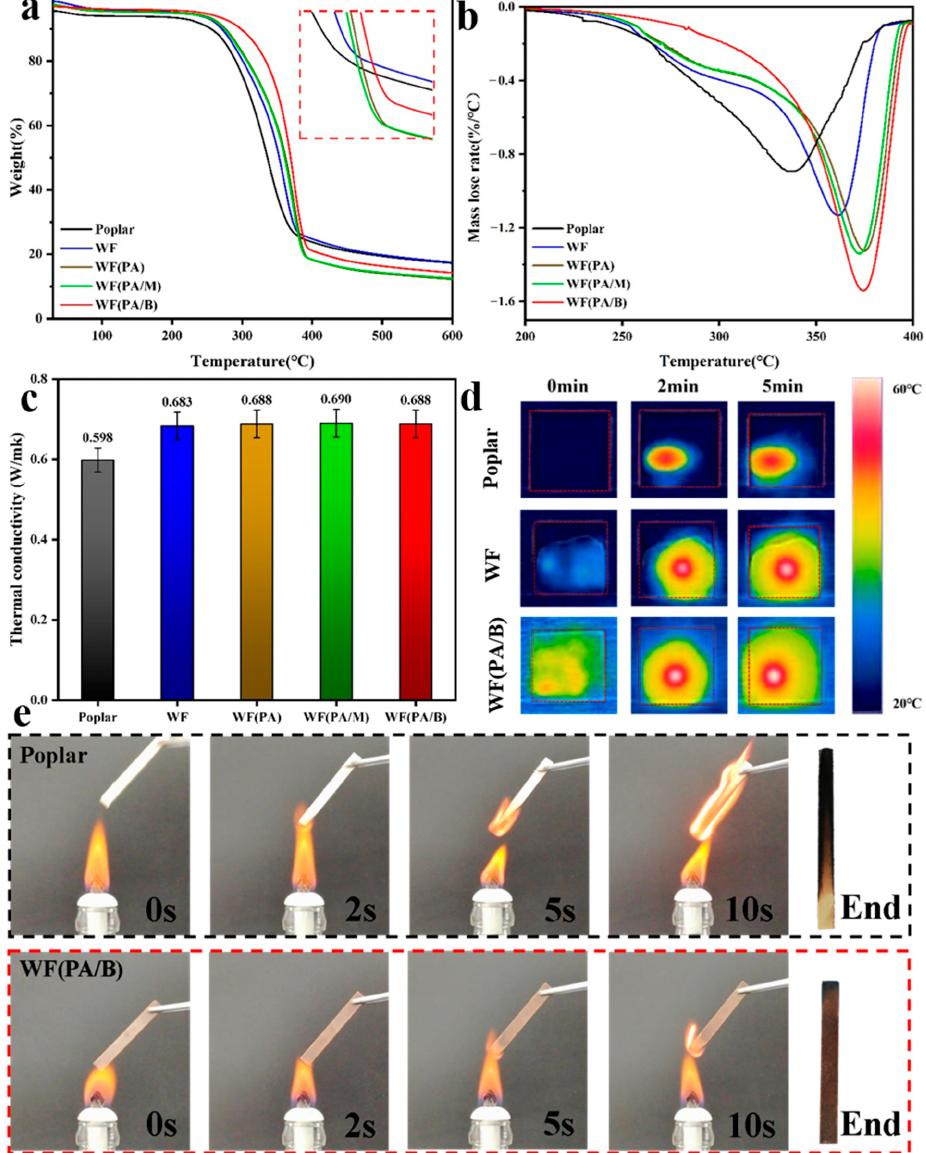
Figure 4. ( a ) TGA analysis of raw material and multiple biocomposite products. ( b ) Results of DTG analysis on raw material and multiple biocomposite products. ( c ) Thermal conductivity of raw material and multiple biocomposites products. ( d ) Thermal imaging of raw material, WF and WF(PA/B). ( e ) Combustion process image of poplar and WF(PA/B).